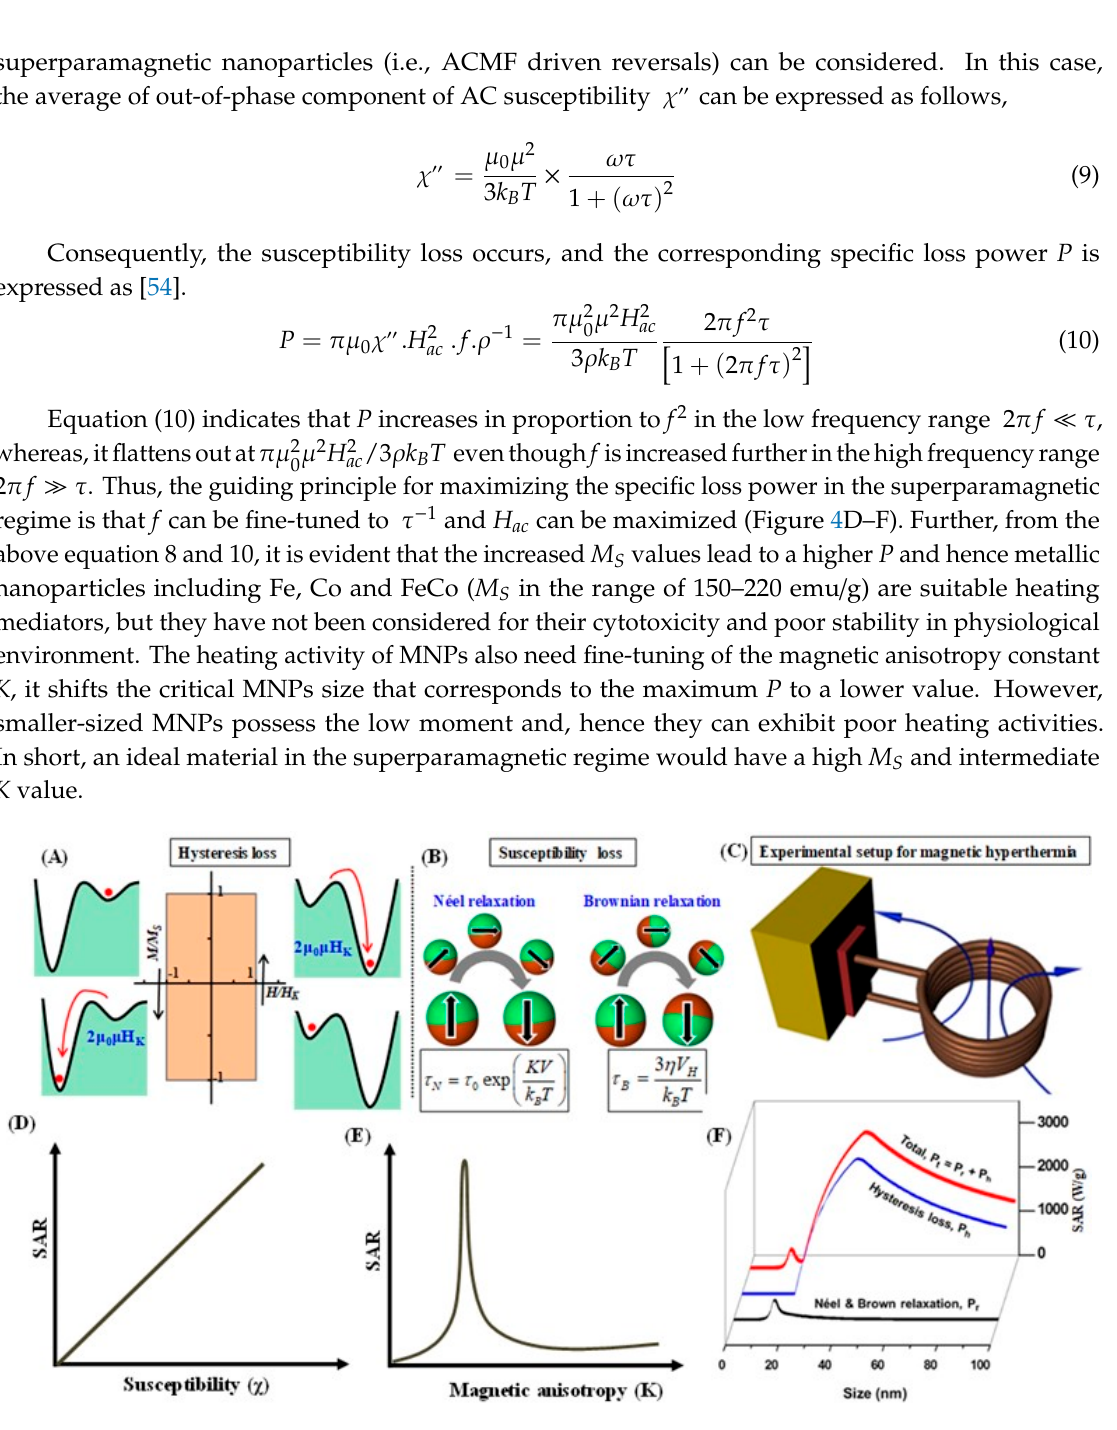
Figure 4. ( A ) Schematic view of the hysteresis loss in a ferromagnetic nanoparticle. Hysteresis loss in one cycle of ACMF is related to the area of the hysteresis loop and the Zeeman energy in magnetic field [56,57]. ( B ) Susceptibility loss given by the out-of-phase component of AC susceptibility is associated to the nanoparticle’s relaxation. As demonstrated in the schematic, in Néel relaxation, the magnetic moment shown by the black arrow reverses (the particle does not rotate), while in Brownian relaxation, the particle (the sphere) rotates as a whole. ( C ) Schematic view of a typical hyperthermia setup. The variation of SAR based on ( D ) susceptibility ( χ ) and ( E ) magnetic anisotropy ( K ). ( F ) Size dependent SAR resulting from the susceptibility loss and the hysteresis loss [55].